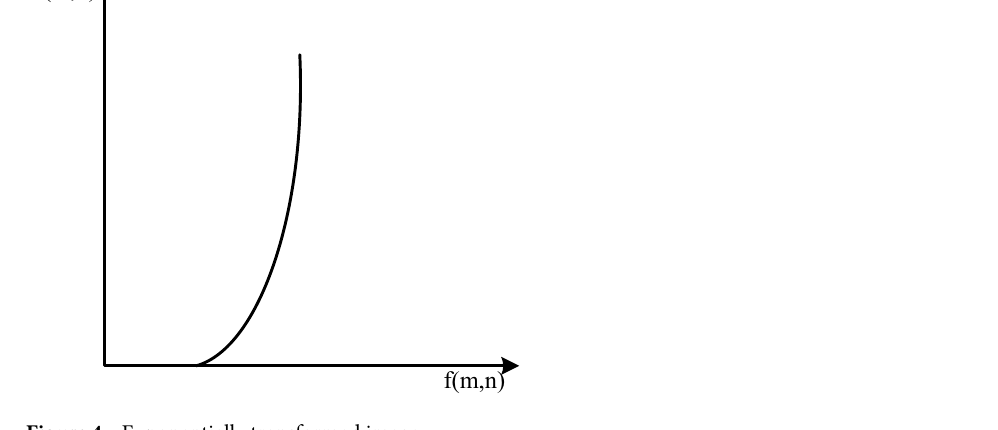
Figure 4. Exponentially transformed image.